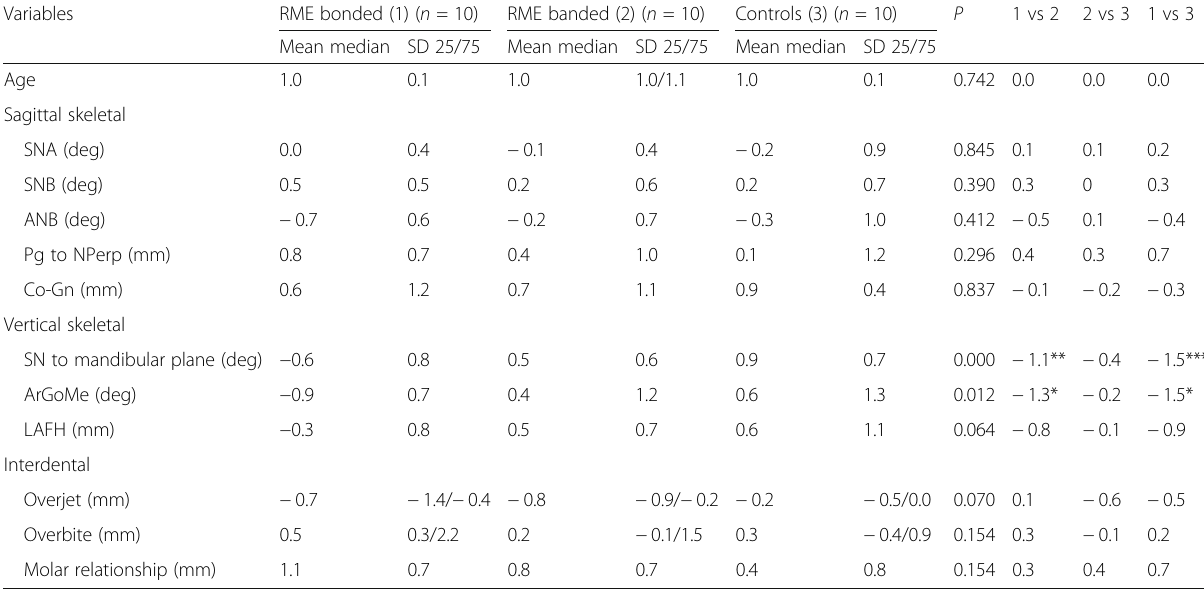
Table 2 Descriptive statistics and statistical comparisons on the T2 – T1 changes (Kruskal-Wallis test or ANOVA or with Tukey ’ s post hoc tests)